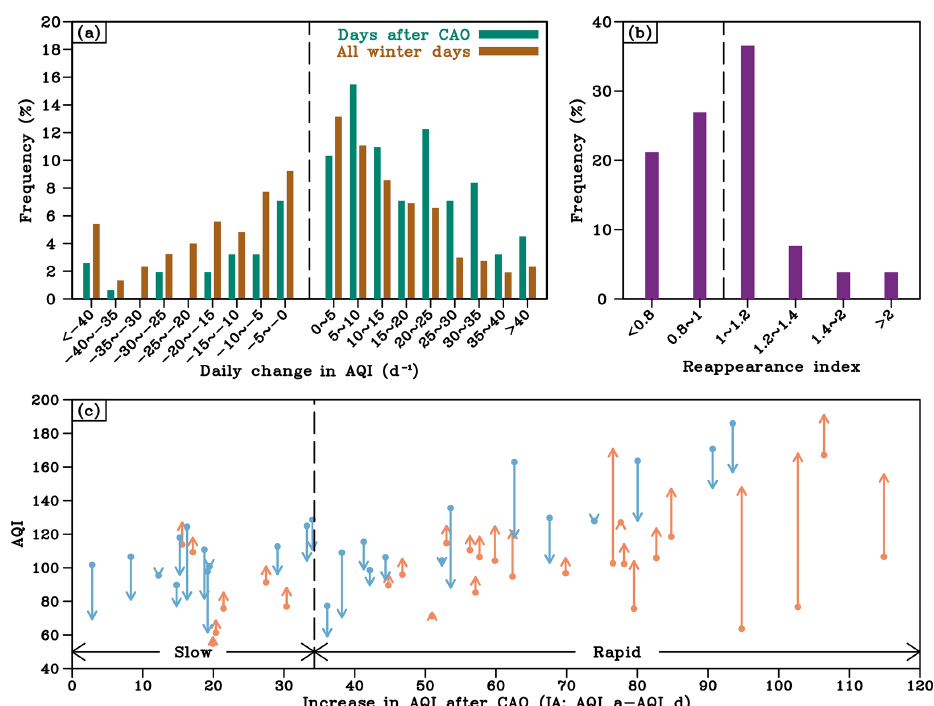
Figure 3. (a) Statistical distribution of the daily change in AQI calculated by all of the days during the eight winters (brown bars) and days during the period after the CAOs (green bars). (b) Statistical distribution of the reappearance index of air pollution in 52 CAO events. (c) The increase in the AQI ( x axis) and the change in the AQI from the period before the CAO to the period after CAO (vertical arrows) in 52 CAO events. The black dashed line denotes the standard deviation of AQI. The arrowhead and tail represent AQI_ a and AQI_ b , respectively. The orange (blue) arrows denote that the AQI worsens (improves) after